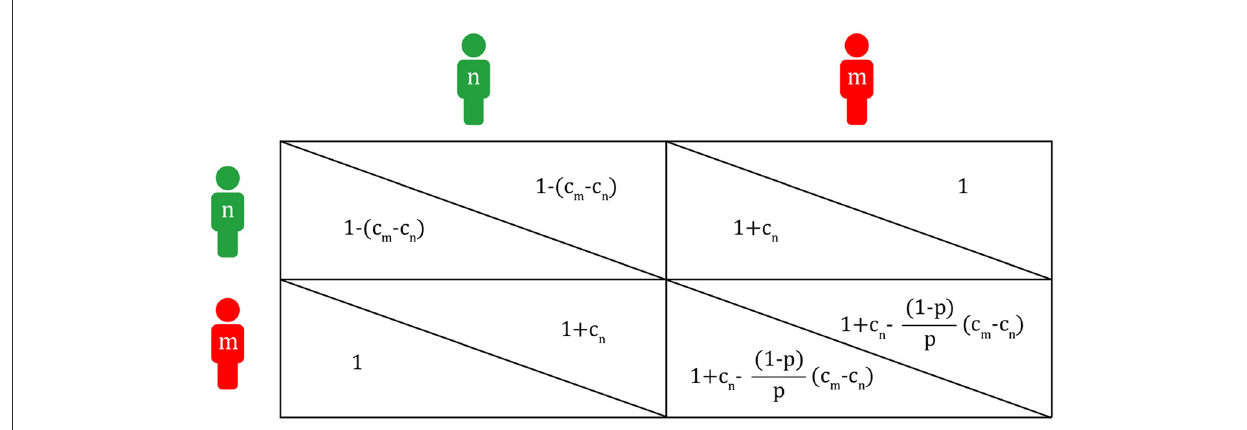
FIGURE5 Payoff matrix of the Migraineur-Non-Migraineur game (n, non-migraineur; m, migraineur; c m , cost of migraineur; c n , cost of non-migraineur; p, population proportion of migraineurs).